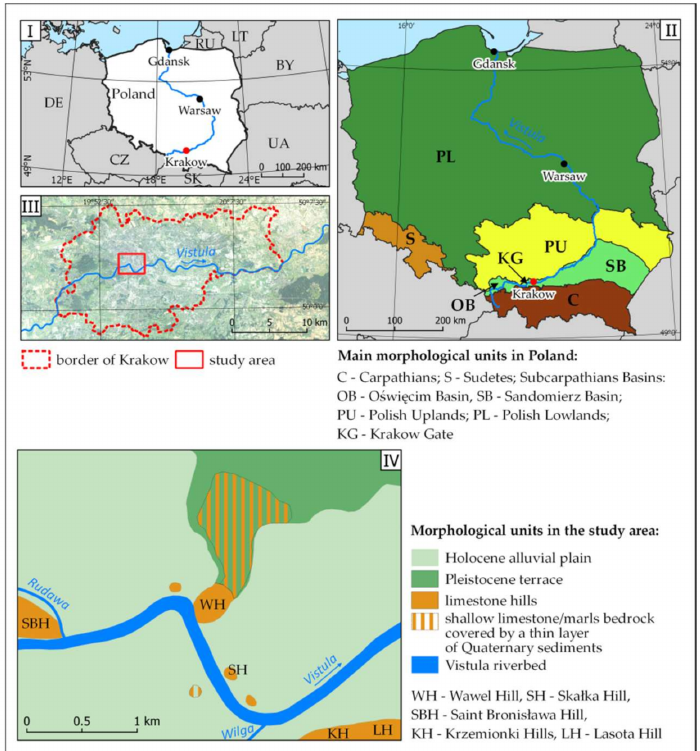
Figure 1. Location of Krakow in Europe ( I ) and in Poland ( II ) on the background of limit of morphological units. Location of the study area within borders of Krakow territory ( III ). Limit of morphological units within the study area ( IV )